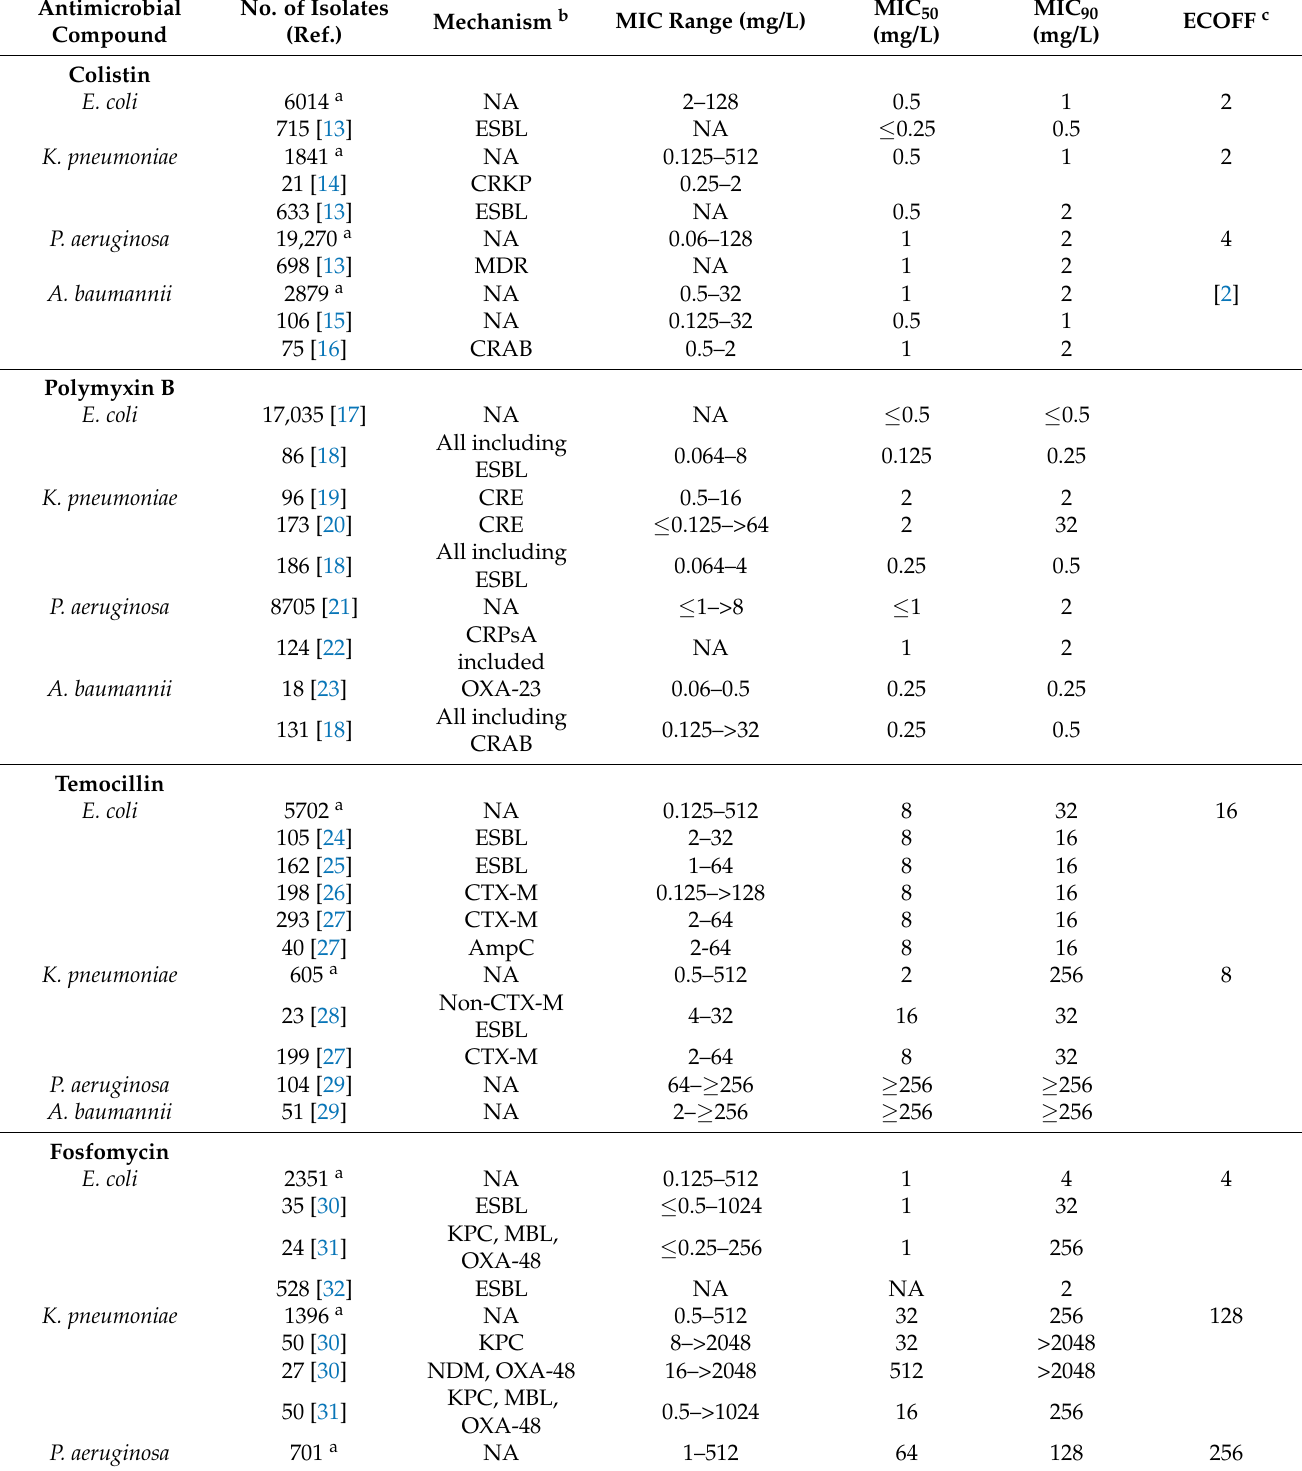
Table 1. In vitro activity of old antibiotics against most common gram-negative